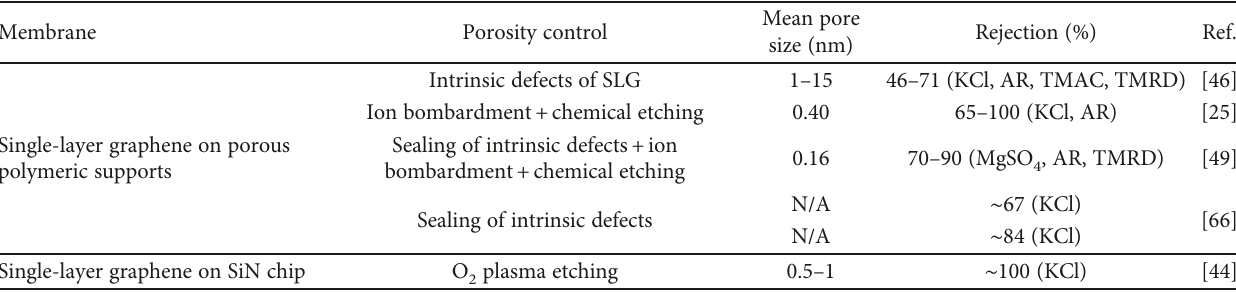
Mean pore Rejection (%) Ref. size (nm)